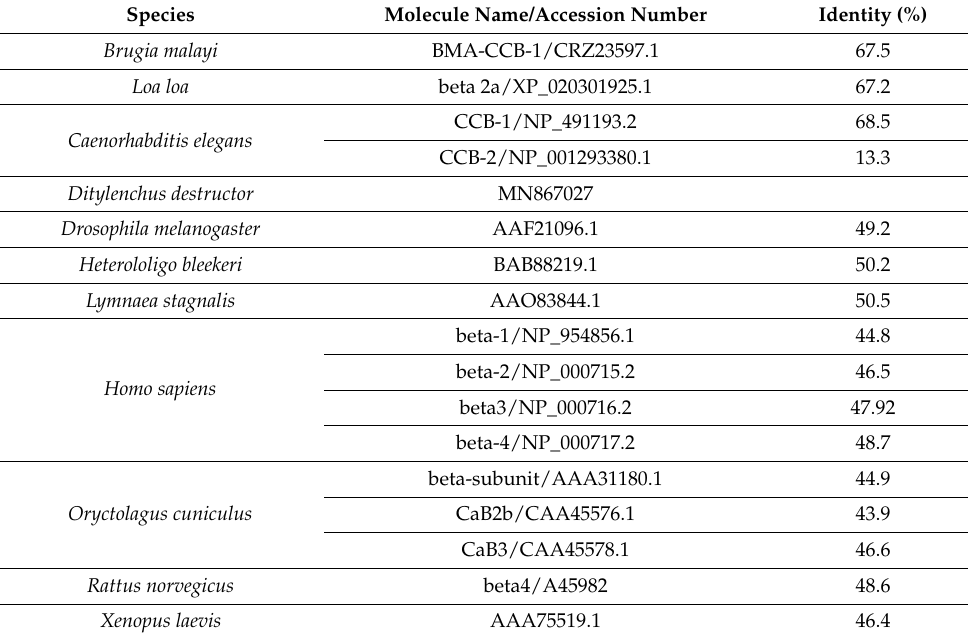
Figure 1. DdCa v β sequence analysis. ( A ), The DdCa v β cDNA sequence and deduced amino acid sequence. The start codon (ATG) and the stop codon (TAA) are indicated in boxes. The fragment that is not translated before the start codon is the 3 (cid:48) UTR, and the fragment that is not translated after the termination codon is the 5 (cid:48) UTR. The underlined area represents SL1 at the front end of the 5 (cid:48) UTR and the poly-A tail at the end of the 3 (cid:48) UTR. The asterisk (*) indicates the stop codon (TAA). The light blue and brown colors indicate the NH 2 terminus and the COOH terminus, respectively; yellow, the SH3 domain; purple, the HOOK region; and green, the GK domain. The residues that are involved in interactions with the AID are marked with the “ • ” symbol. ( B ), The predictive structure of DdCa v β . Table 1. Ca v β information used for sequence alignment and phylogenic